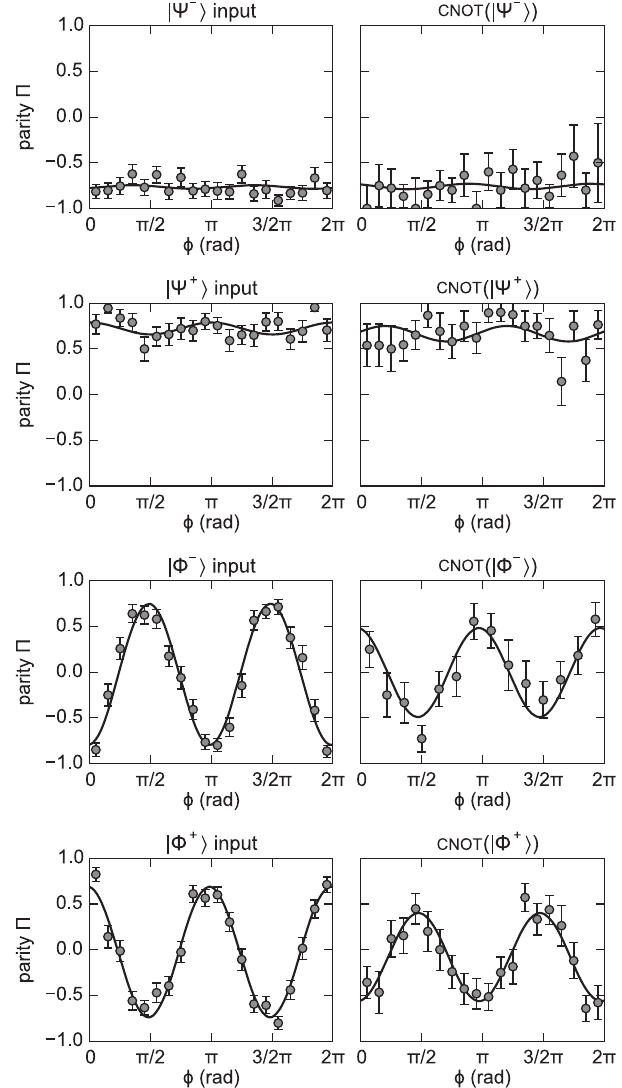
FIG. 5. Parity signals of input and output states of the CNOT gate. The left-hand column shows Π ð ϕ Þ for all four prepared Bell states used as input states for the gate. The right-hand column shows the respective parity signals after the gate. While the states j Ψ (cid:3) i remain basically unchanged by the gate operation, one can observe the swap j Φ (cid:3) i → j Φ ∓ i as a π = 2 phase flip in the respective parity oscillation signal. Error bars are statistical standard errors of each data point. The solid lines are fitted sine curves with free offset, amplitude, and phase, which are used to compute the